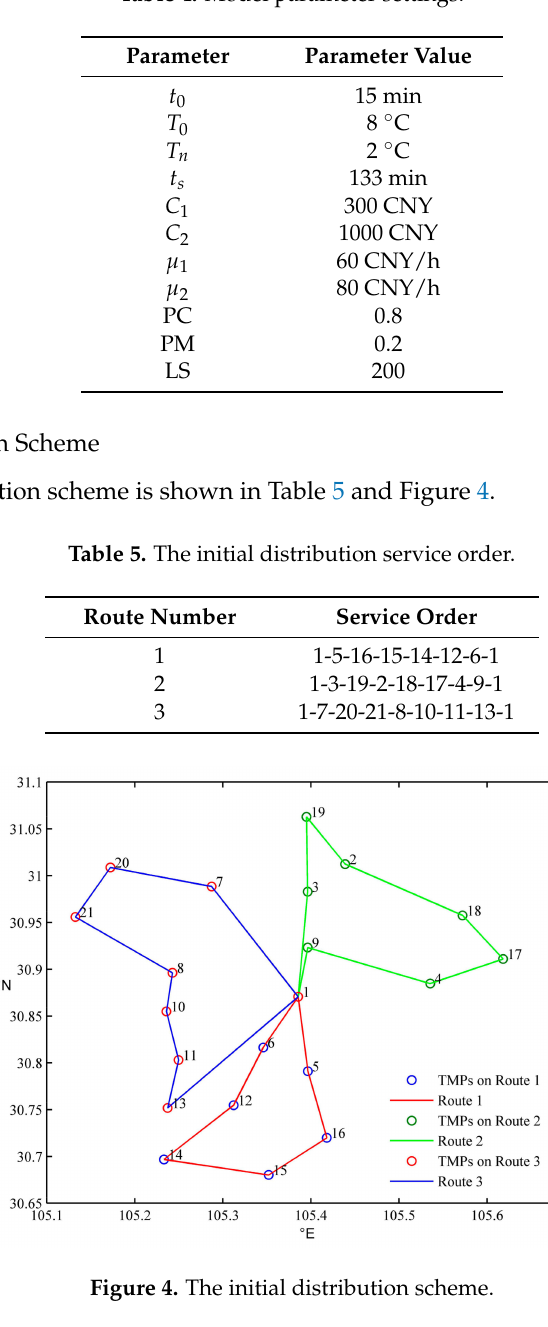
Figure 4. The initial distribution